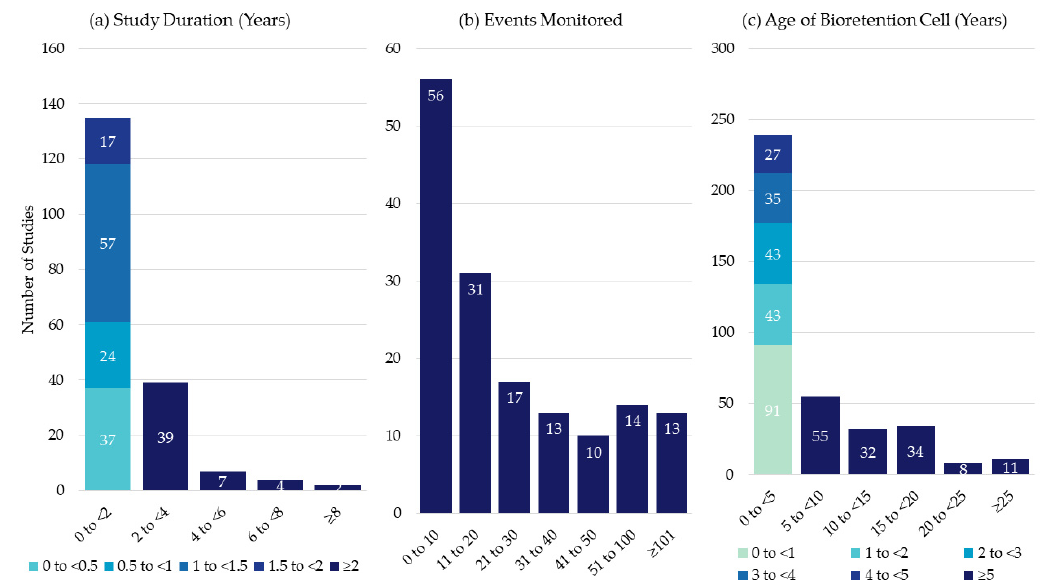
Figure 9. Number of Field Studies by Study Duration ( a ), Number of Events Monitored ( b ) and Age of Bioretention Cell ( c ).